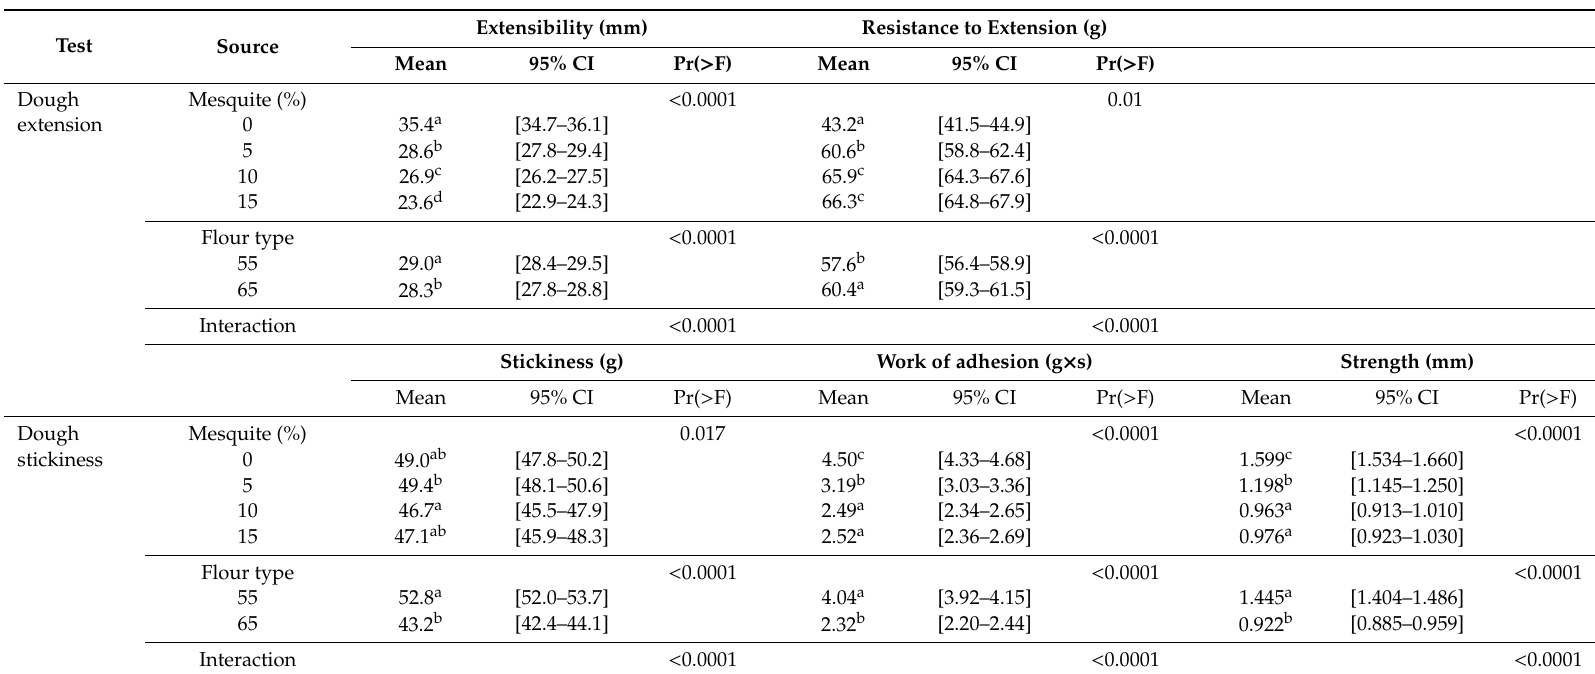
Table A1. Combined e ff ect of mesquite flour substitution level and wheat flour type on the properties of extension and stickiness of composite doughs, showing means and 95% confidence